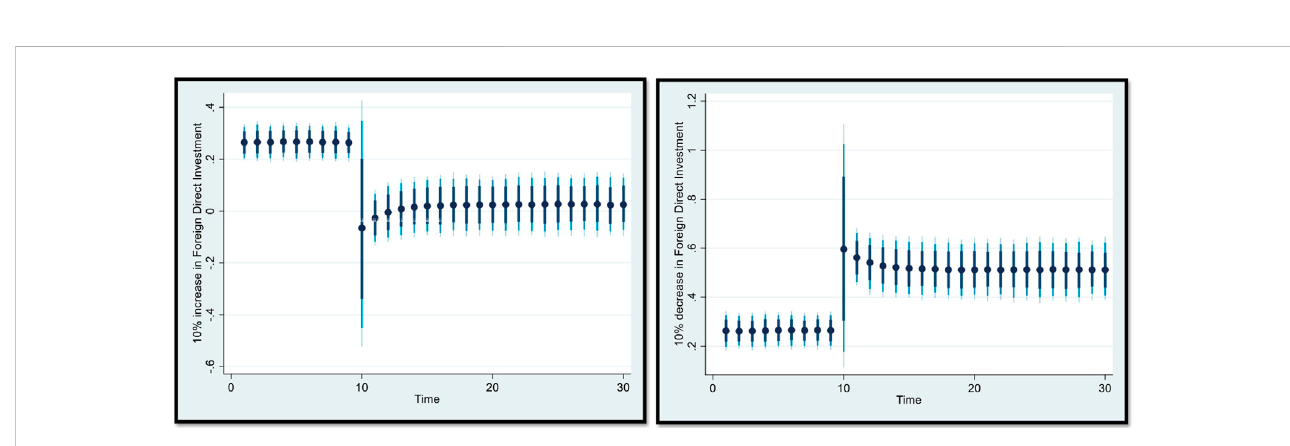
FIGURE 5 Impulse response plot for foreign direct investment and CO 2 emissions. An increase and a decrease of 10% in foreign direct investment and its effect on CO 2 emissions, where dots denote the average prediction value. The dark blue to light blue lines show 75%, 90%, and 95% con fi dence intervals,